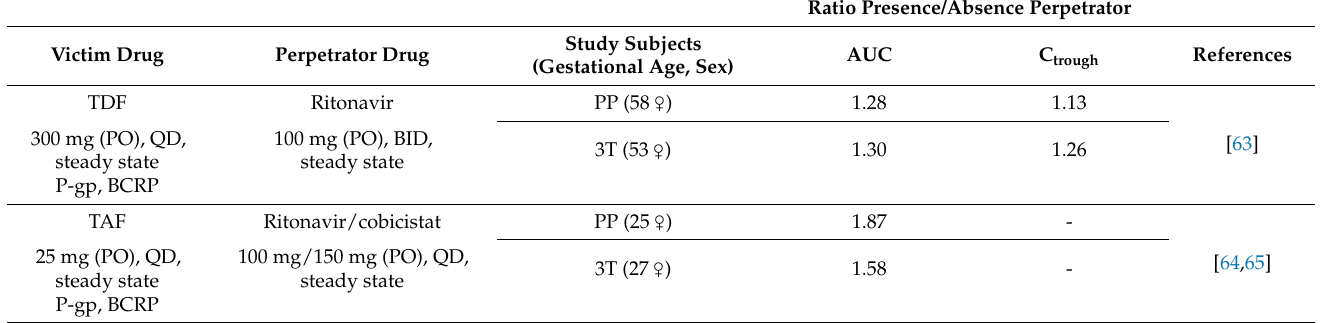
Table 7. Comparison of DDI magnitudes impacting absorption in pregnant women relative to non-pregnant individuals.